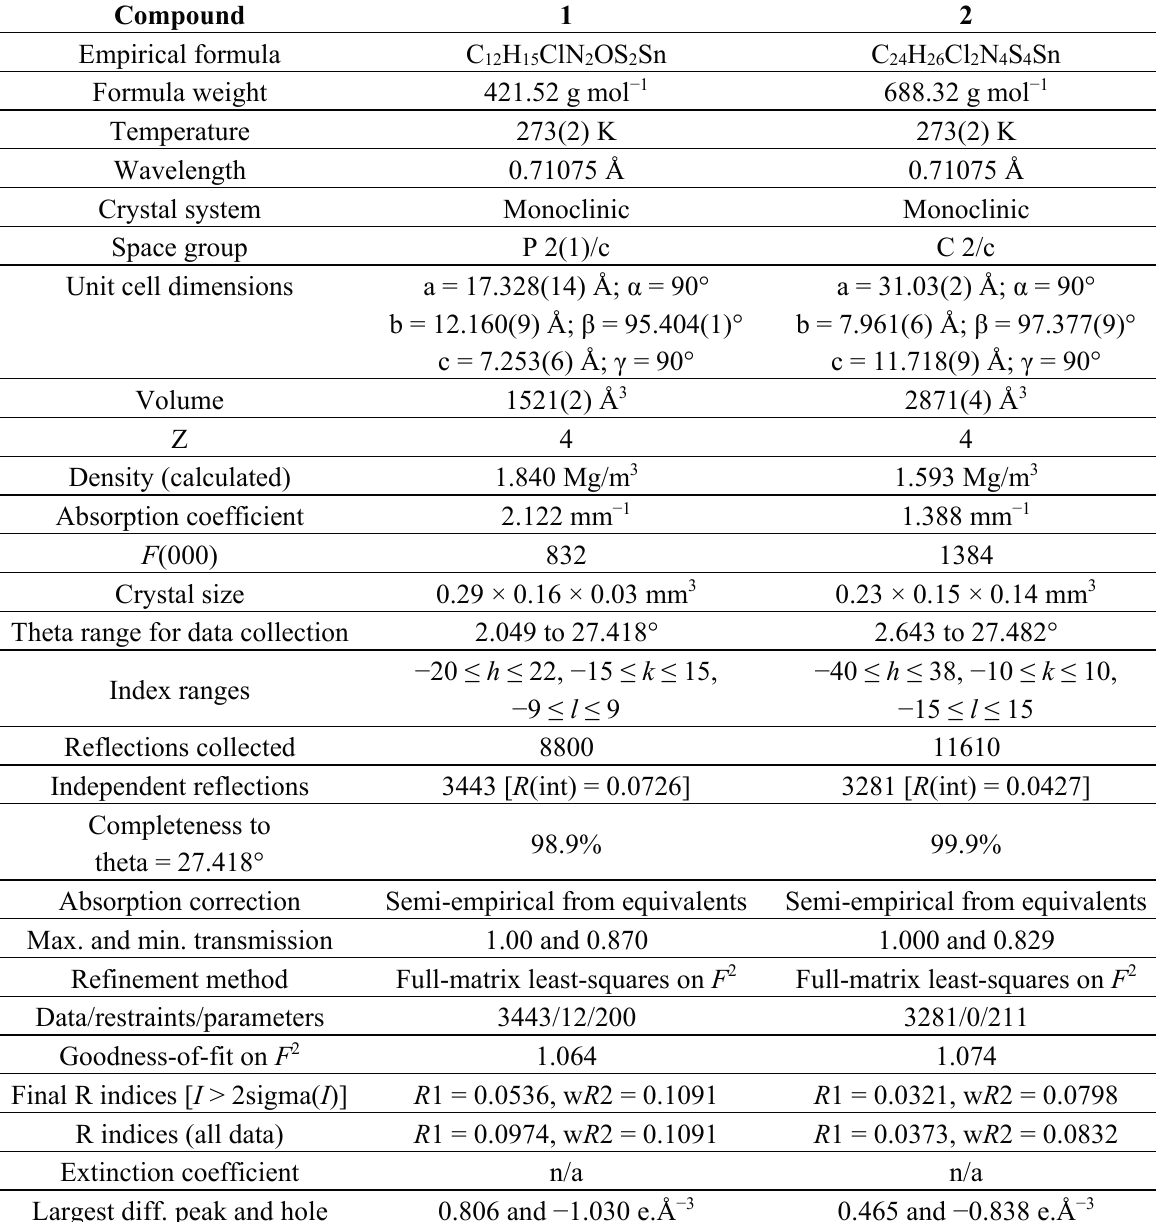
Table 1. Crystallographic data for compound 1 and 2